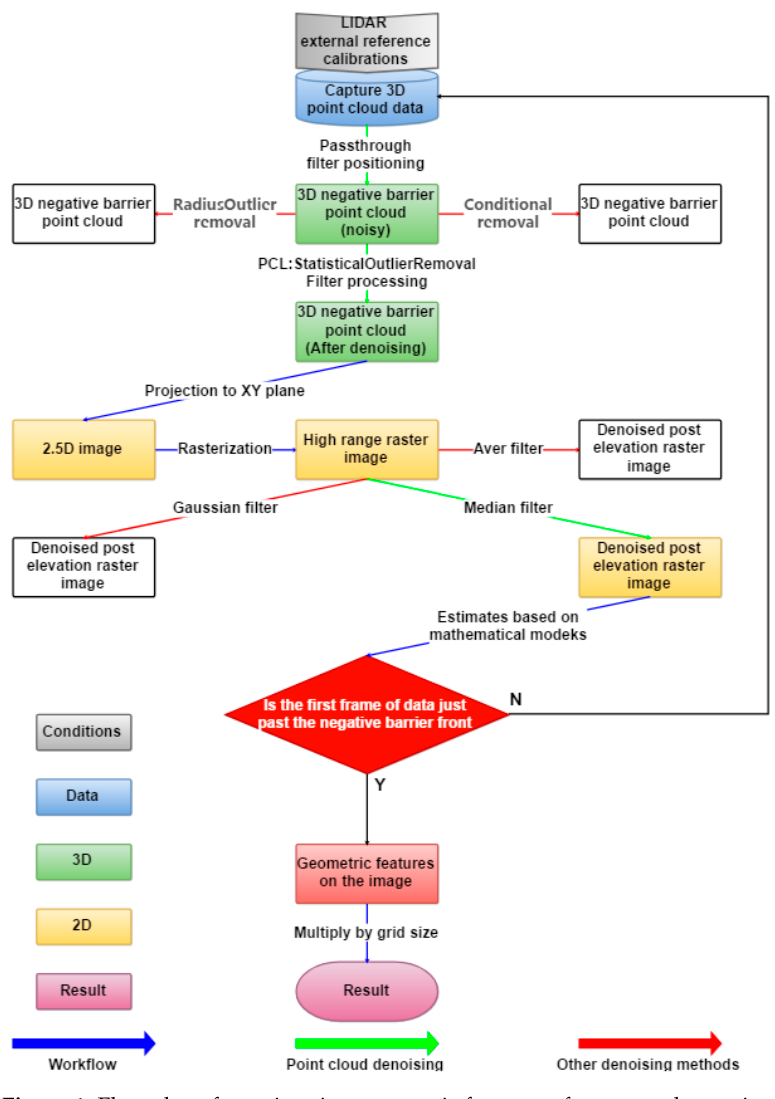
Figure 1. Flow chart for estimating geometric features of structured negative obstacles based on a single-frame 3D laser point cloud.